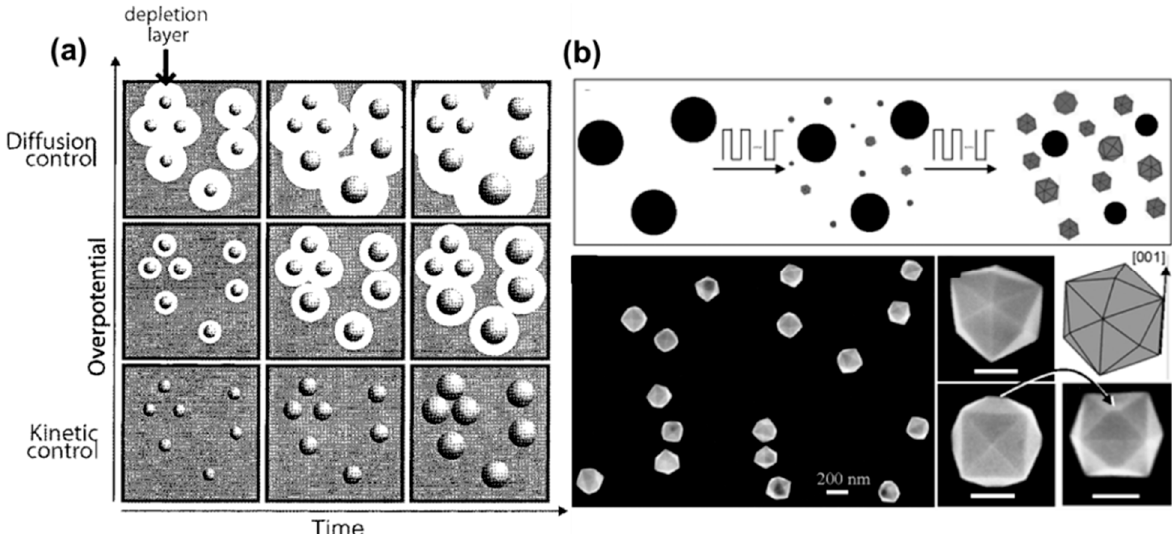
Figure 4. Electrochemical synthesis of metal NPs. ( a ) Schematic showing the effect of overpotential on the reaction rate and the size dispersity of metal NPs synthesized via electrochemical deposition. ( b ) Top: Scheme of electrochemical preparation of tetrahexahedral Pt NPs from spherical NPs. By applying a squarewave potential, new Pt NPs grow at the expense of the large spherical NPs that dissolve, while the newly nucleated NPs eventually transform into tetrahexahedral shapes. Bottom: typical SEM images of the Pt NPs. Scale bars: 100 nm. ( a ) Reprinted with permission from ref. [54]. Copyright 2002 American Chemical Society. ( b ) From [61]. Reprinted with permission from AAAS.